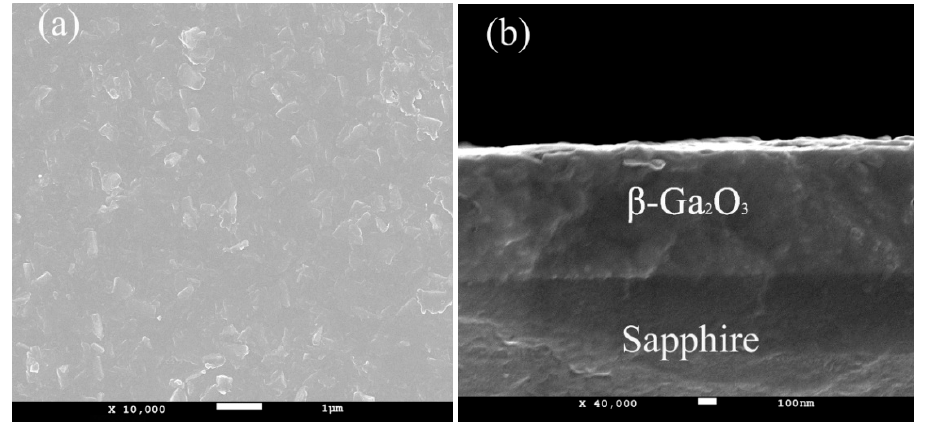
Figure 4. FESEM images of β -Ga 2 O 3 films grown with VI/III ratio of 11.2 × 10 3 : ( a ) Top-view; ( b ) cross-sectional view.